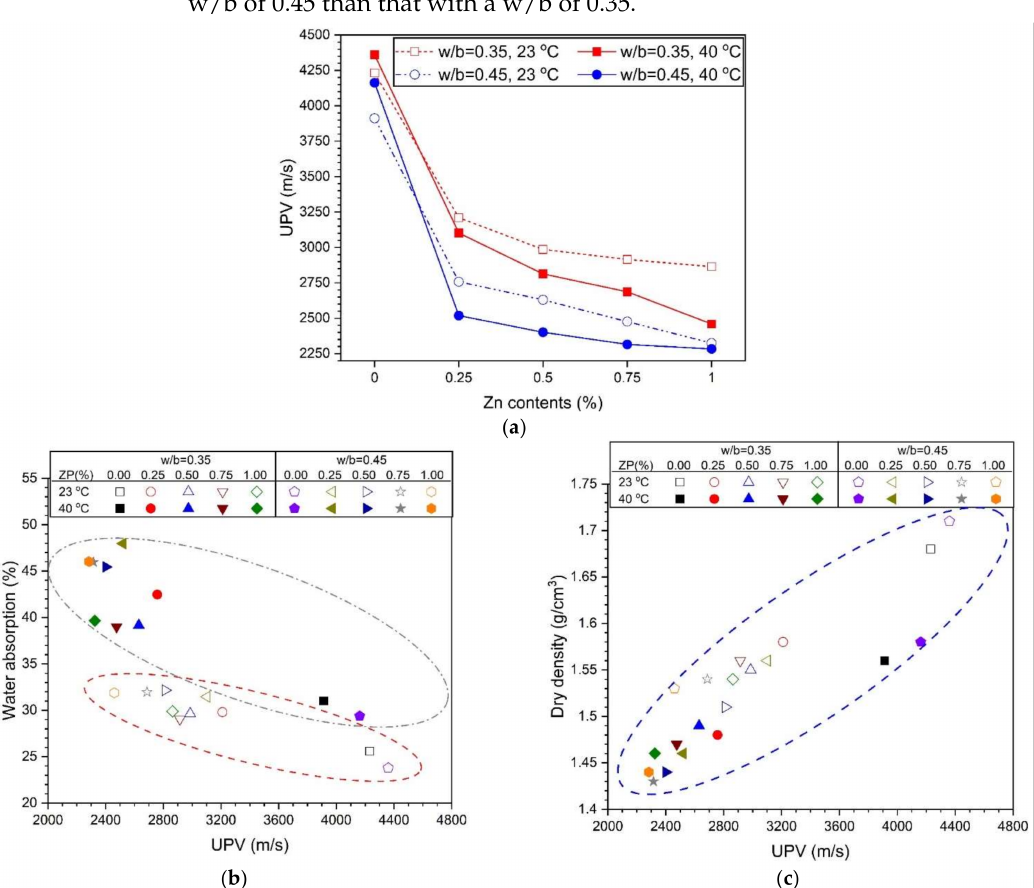
Figure 8. ( a ) Variations of UPV with Zn content, ( b ) water absorption with UPV, and ( c ) dry density with